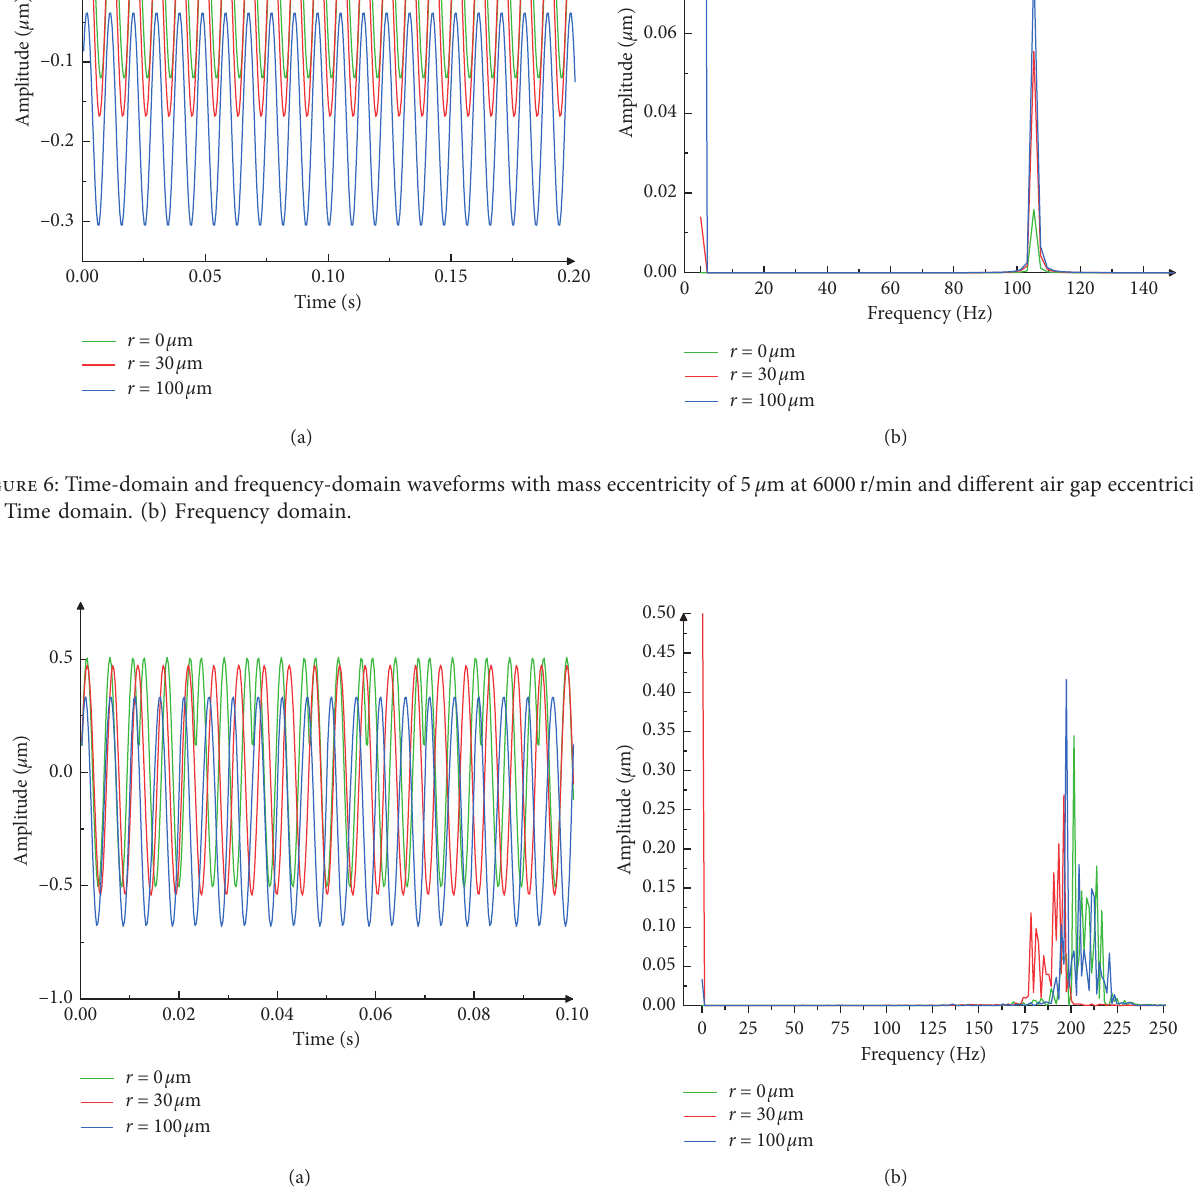
Figure 7: Time-domain and frequency-domain waveforms with the rotating speed of 12000r/min, mass eccentricity of 5 µ m, and different air gap eccentricity. (a) Time domain. (b) Frequency